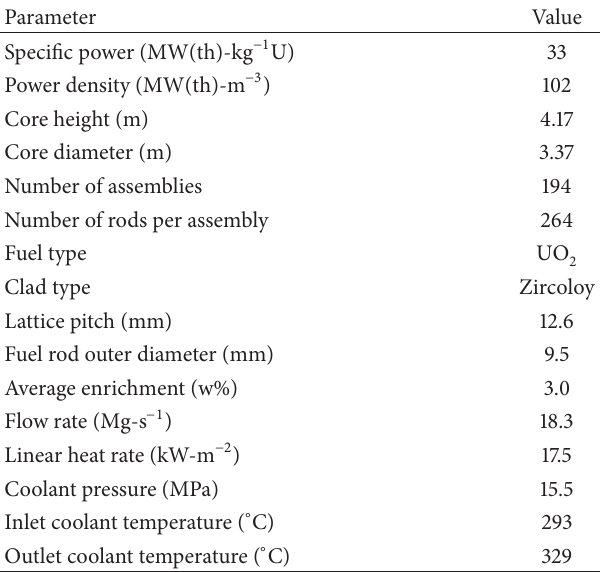
Table 3: Typical design specifications of a PWR [13–15, 34]. Parameter Value